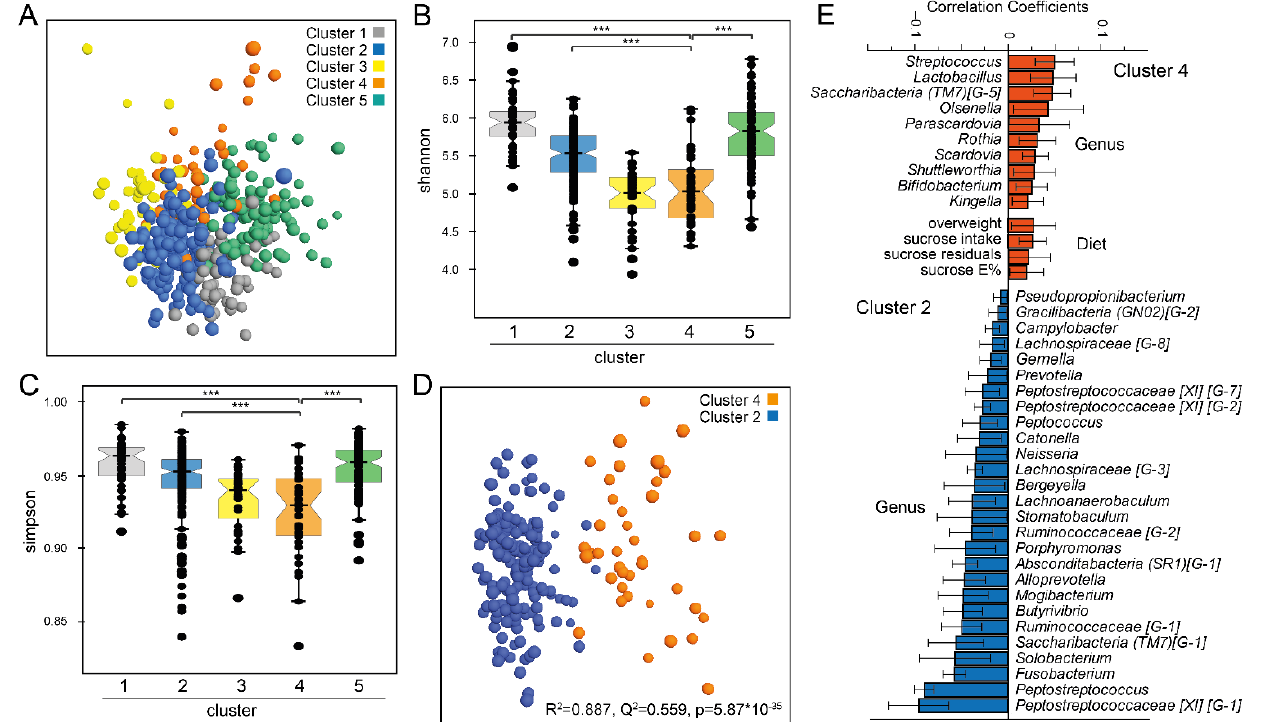
Figure 1. ( A ) PCA score plot based on the relative abundances of the 116 genera, and Box-jitter plots of ( B ) Shannon and ( C ) Simpson diversity indices. ( D ) PLS-DA score plot of participants in cluster 2 and 4 with ( E ) PLS correlation coefficients with 95% CI of genera and sucrose measures (x-variables) that were significantly influential for the separation of the two clusters. Color coding follows that indicated in ( A ) throughout the figure. Group differences were evaluated by PERMANOVA, * for p < 0.05, ** p < 0.01, and *** p < 0.001 (FDR adjusted).